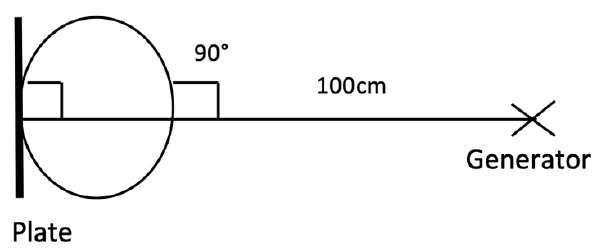
Figure 2. Standardized laterolateral positioning for radiographs.